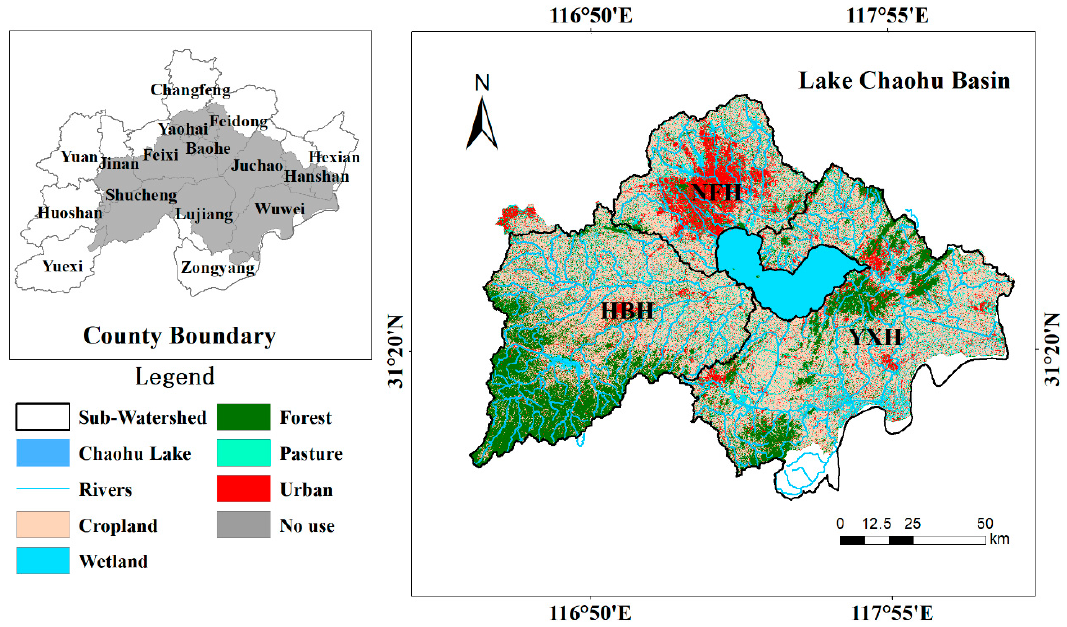
Figure 1. Geographical location and land use of the Chaohu Lake Basin in 2018. (HBH, NFH, and YHX River stand for agricultural, urban, and mixed watersheds, respectively).